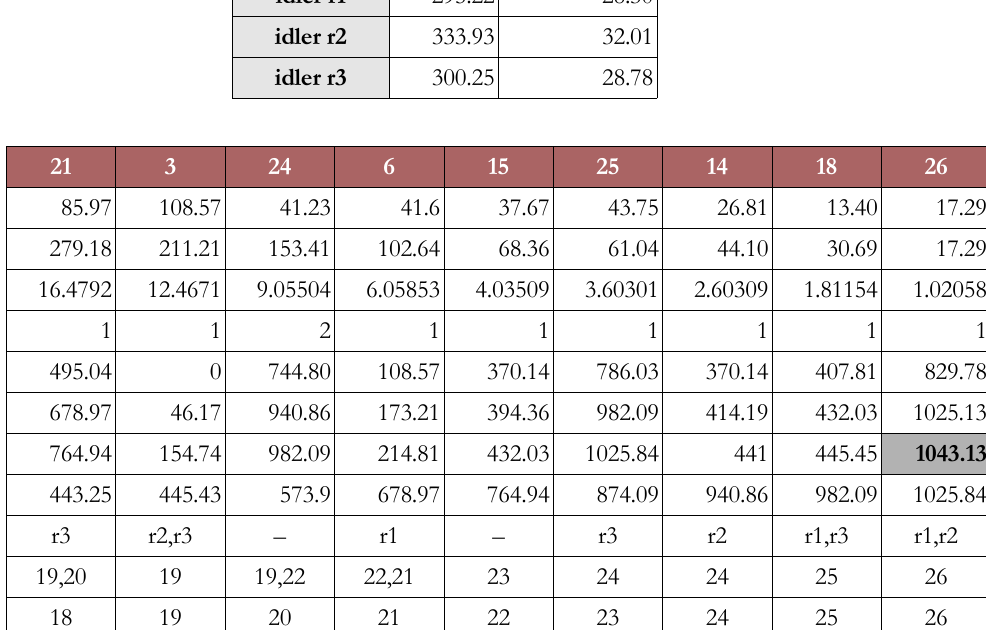
Table 18. TIMRES Scheduling, Rmax = 3, n(r) = 3 (Scenario